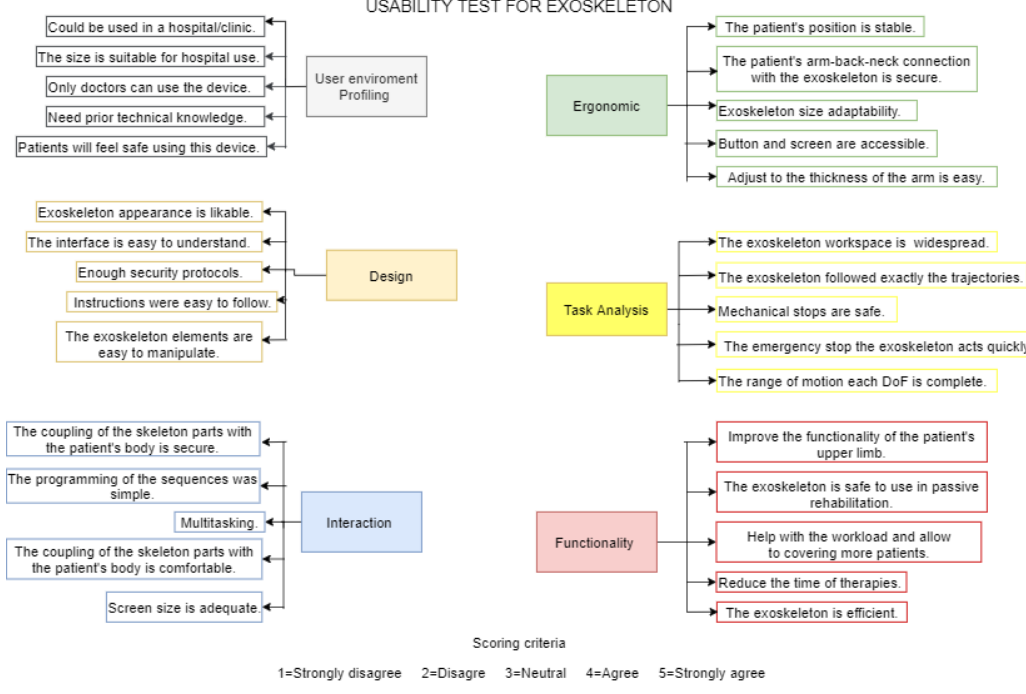
Figure 10. Diagram to explain the usability